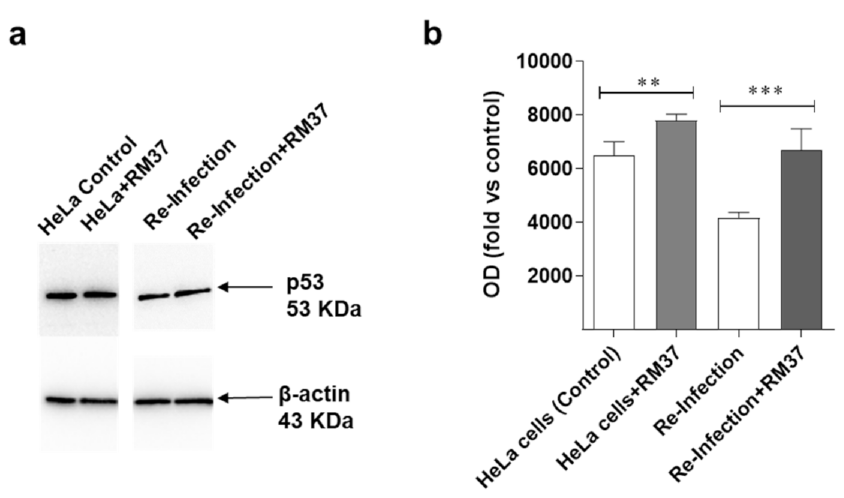
Figure 10. Effects on p53 pathway’s reactivation upon C. trachomatis infection. ( a , b ) HeLa cells were inoculated with C. trachomatis serovar D (ATCC VR-885) at multiplicity of infection (MOI) 0.5 and treated with RM37 . Cell lysates were subjected to Western blot analysis using specific antibody for p53. ( a ) A representative image is shown. Full screen of Western blot assay was provided in a separate file. ( b ) Data are shown as arbitrary optical density (OD) (mean values ± SEM of three different experiments). ** p < 0.01, *** p < 0.001 versus